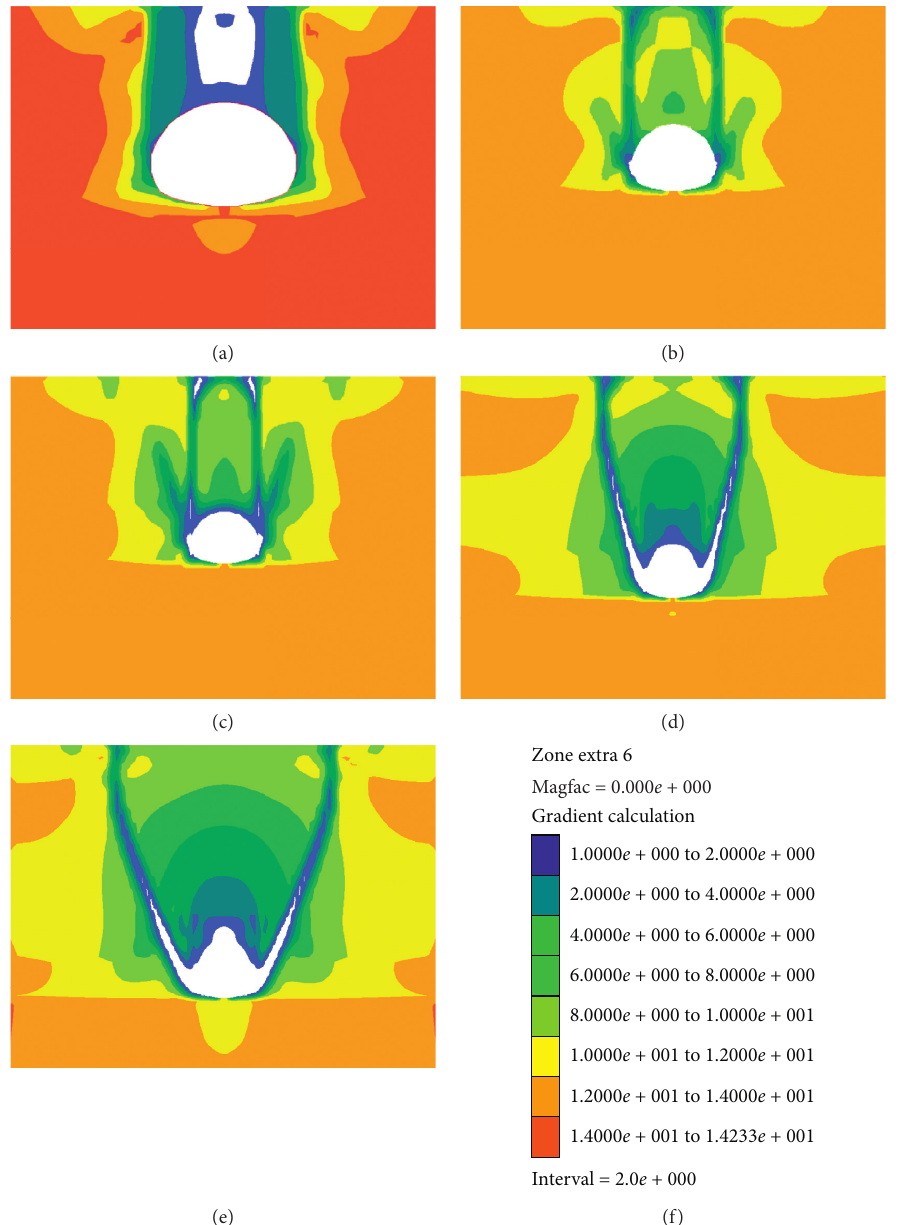
Figure 23: Distribution of structural damage after tunnel excavation. (a) Depth: 10m, (b) depth: 20 m, (c) depth: 30m, (d) depth: 40m, (e) depth: 50m, and (f) generalized